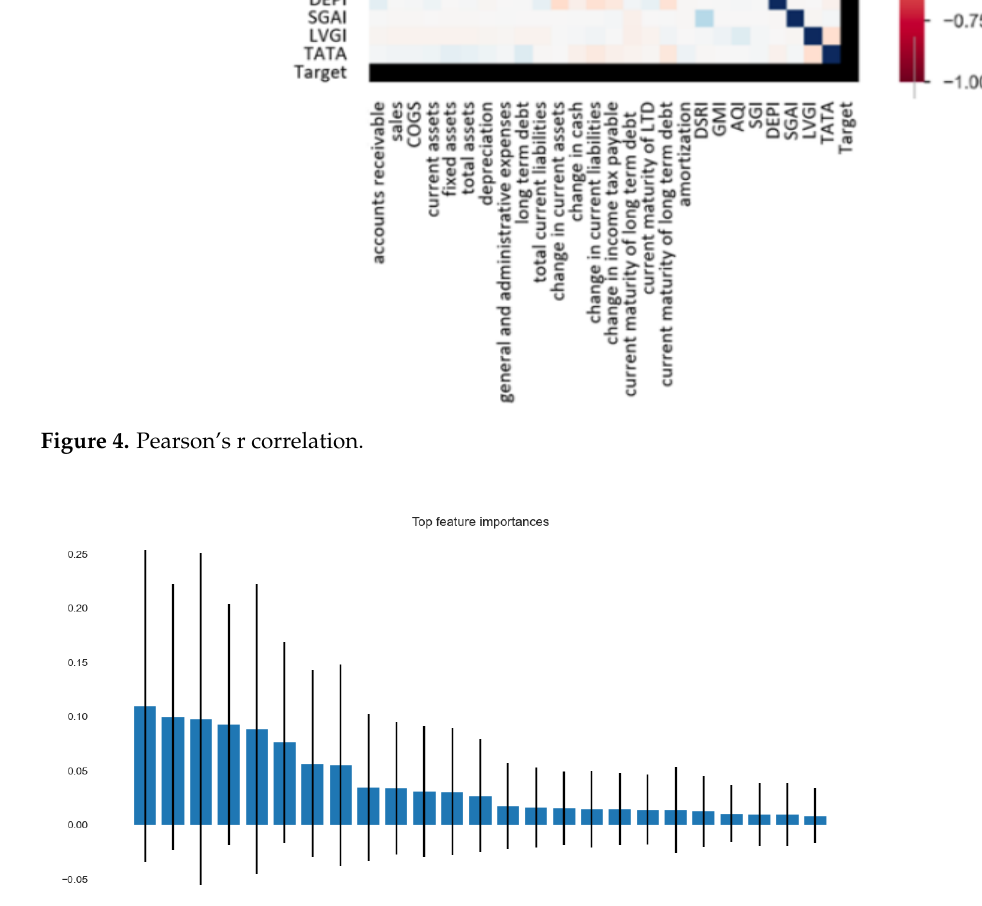
Figure 5. Feature importance of the